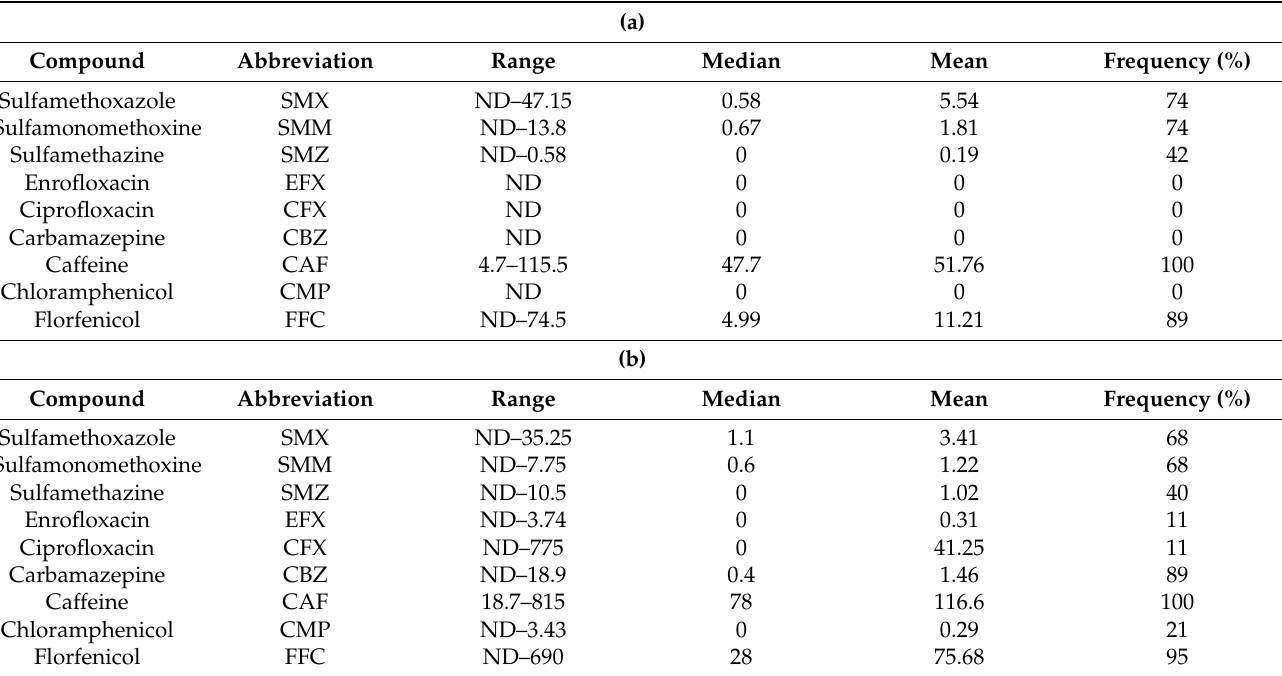
Table 2. ( a ) The descriptive analysis of overall PPCP concentration data of the Lianjiang River in the dry season; PPCP concentration is given in ng L − 1 . ( b ) The descriptive analysis of overall PPCP concentration data of the Lianjiang River in the wet season; PPCP concentration is given in ng L − 1 .